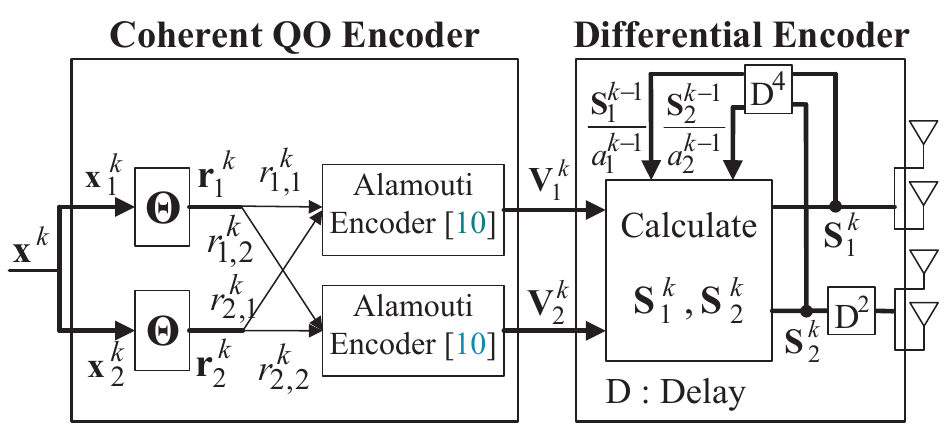
Figure 1. Block diagram of conventional QO-DSTM [7,8] with four transmit